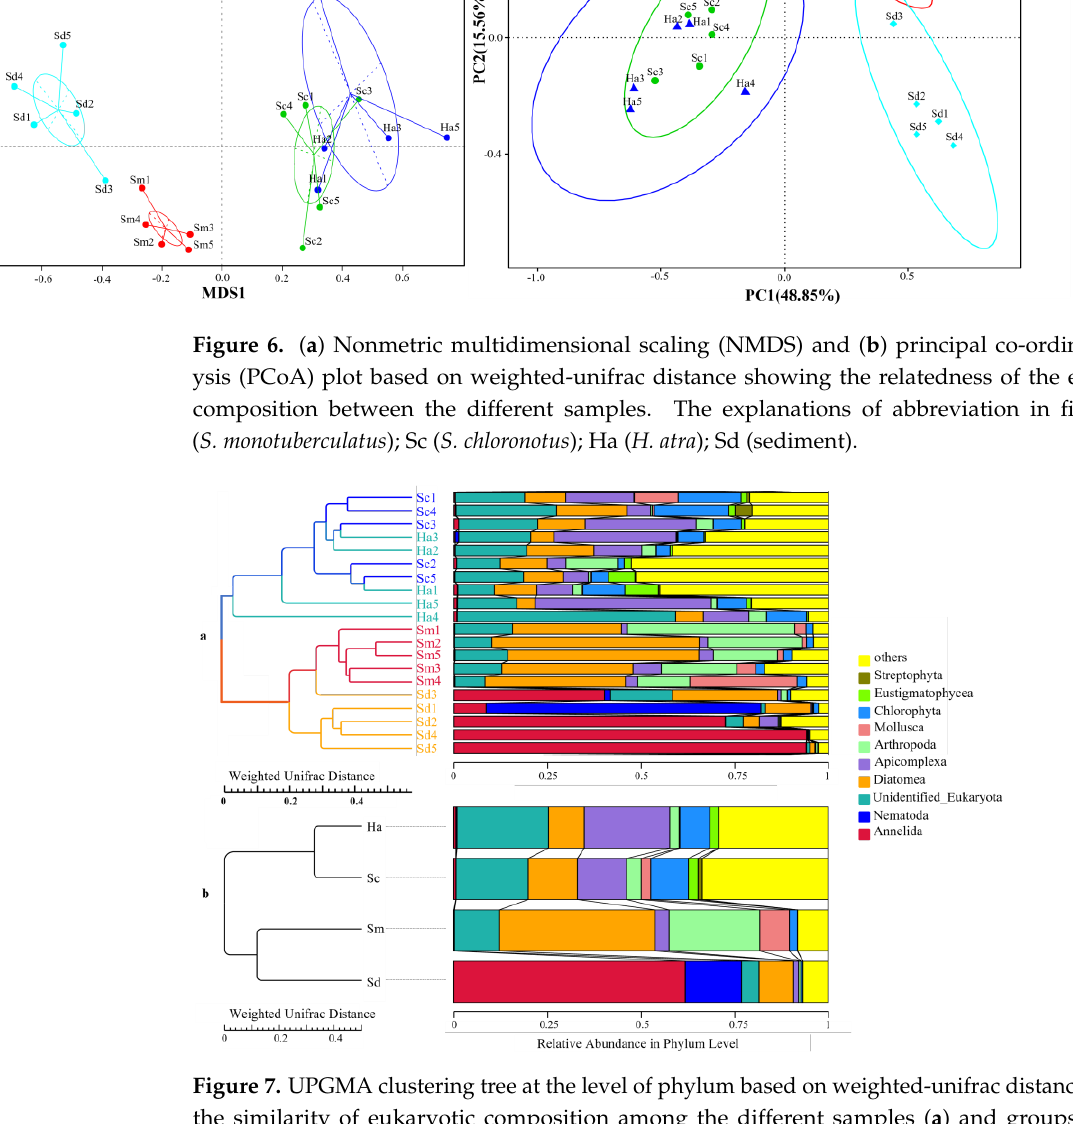
Figure 7. UPGMA clustering tree at the level of phylum based on weighted-unifrac distance showing the similarity of eukaryotic composition among the different samples ( a ) and groups ( b ). The explanations of abbreviation in figure: Sm ( S. monotuberculatus ); Sc ( S. chloronotus ); Ha ( H. atra ); Sd